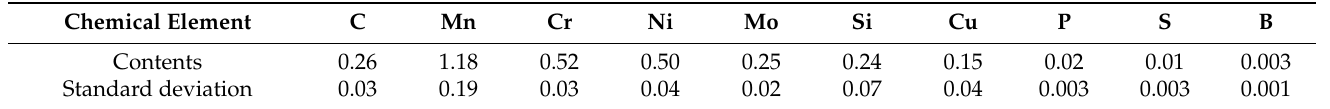
Table 1. Average chemical composition and standard deviation of the tested steel from seven heats (wt.